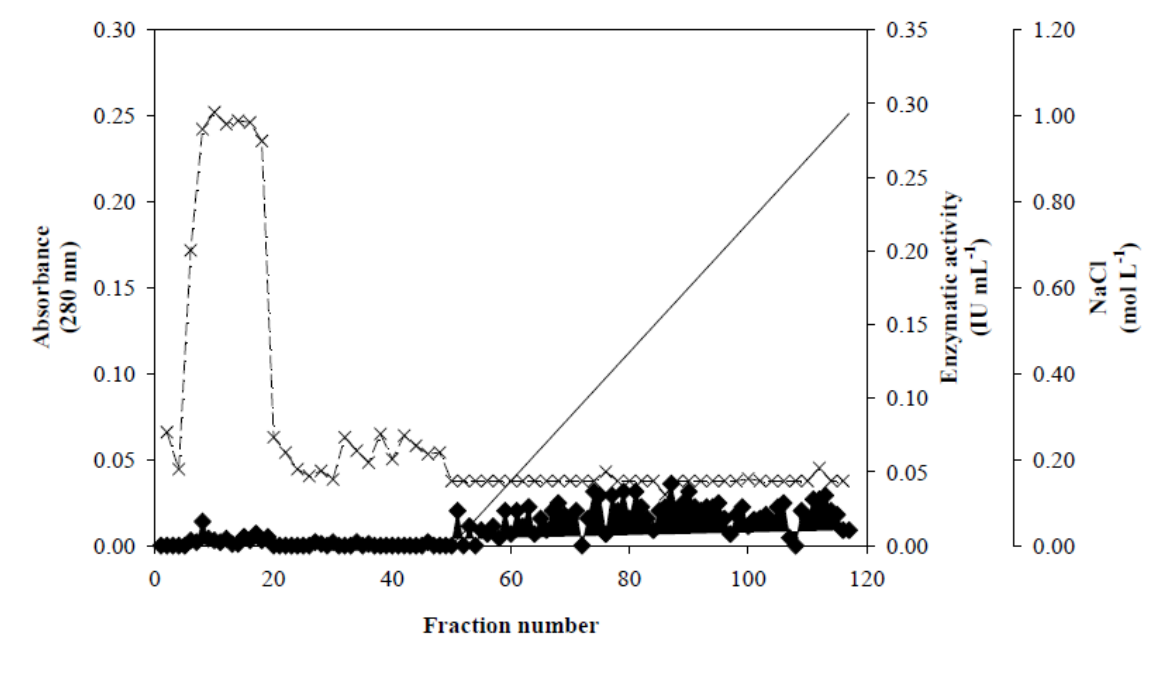
Figure 1. Ion exchange chromatography of Xyl-O1 on Q-Sepharose. Absorbance at 280 nm is represented by closed diamonds [ ], xylanase activity is represented by thin Xs [ ], and the linear gradient (0–1.0 mol·L − 1 NaCl in equilibration buffer) is represented by a solid line [ ].